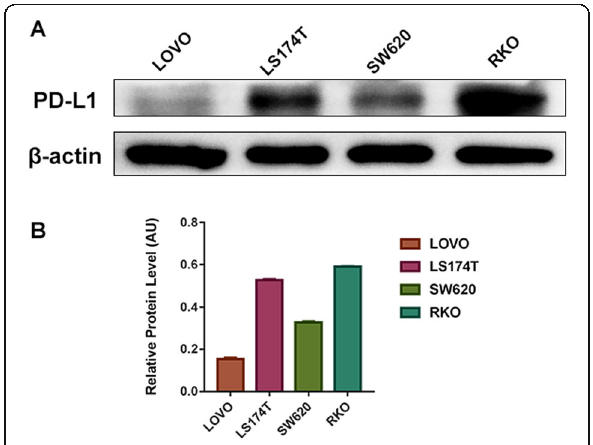
Fig. 1 PD-L1 total protein expression analysis of four CRC cell lines. a Western blot analysis of total cell lysates using anti-PD-L1 and anti- β -actin antibody between LoVo, LS174T, SW620, and RKO in vitro. b The ratio of PD-L1 total protein intensity. Data are expressed as means± SD, *** p < 0.001 ( n =